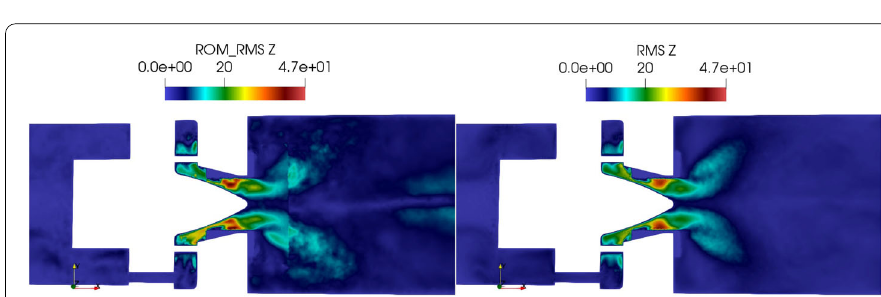
Fig. 51 Smaller RFD. On the left, the second component of the root mean square flow field by the UGPOD applied to configuration 1. On the right, the second component of the high fidelity root mean square flow field with configuration 1